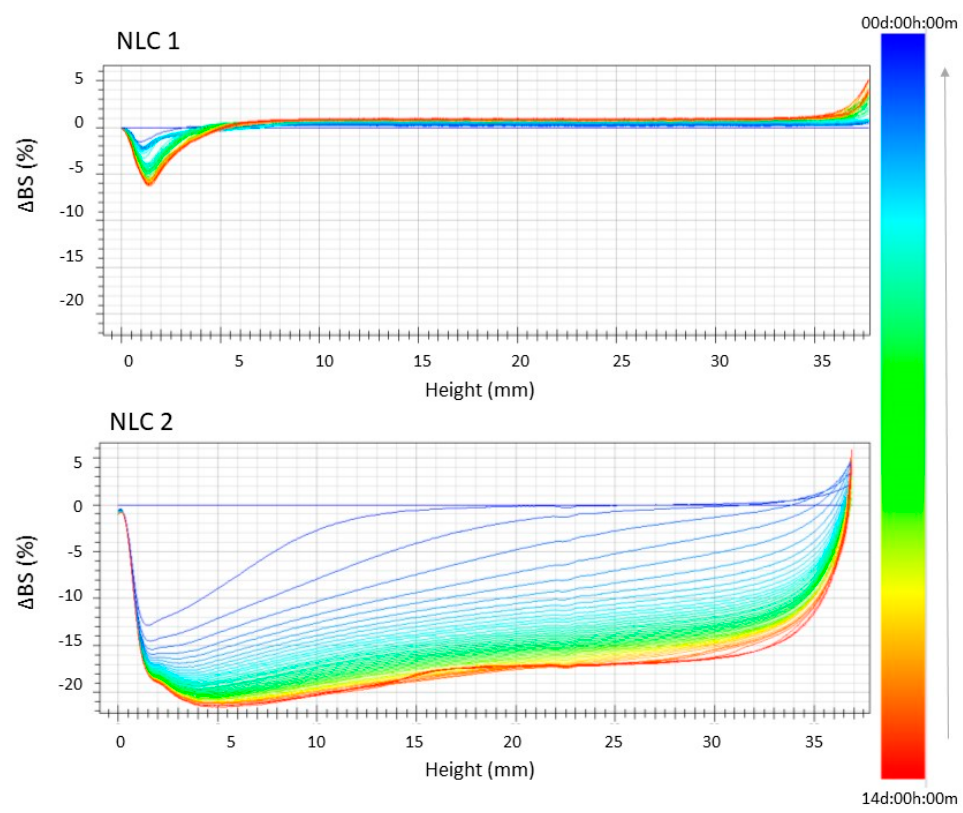
Figure 2. Backscattering profiles ( ∆ BS) of NLC 1 and NLC 2 stored in Turbiscan ® at 25.0 ± 1.0 ◦ C. Data are represented as a function of time (0–14 days) of sample height (0–20 mm). The sense of analysis time is indicated by the arrow.